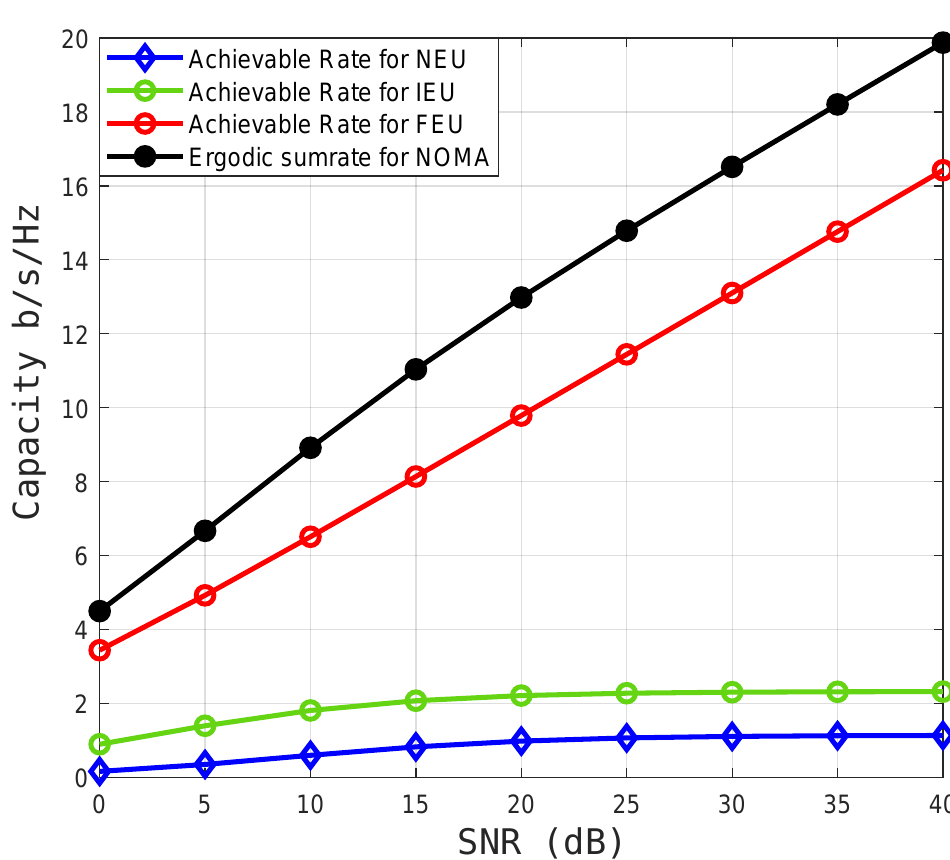
Figure 13. Capacity performance of the NOMA system for more than 2 EU (3